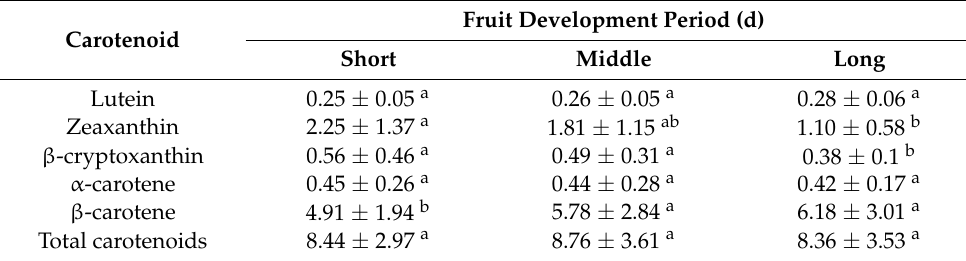
Table 3. Carotenoid concentrations of yellow-flesh peach with different fruit developmental periods. Fruit Development Period (d) Carotenoid